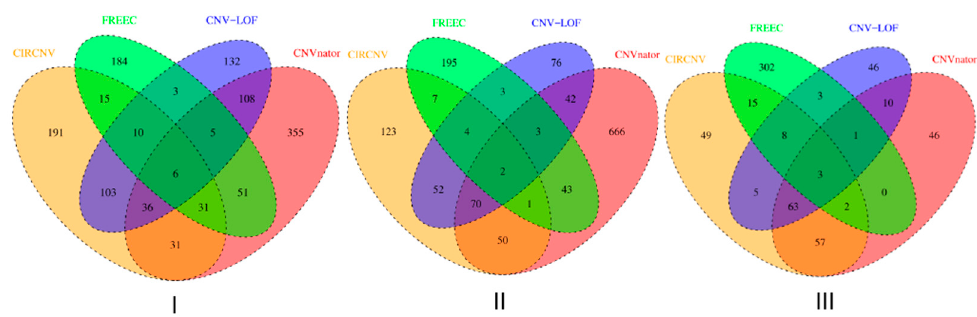
Figure 6. Result comparison of the four methods on the whole-genome sequencing data from sam- ples of EGAR00001004802_2053_1 ( I ), EGAR00001004802_2053_1 ( II ), and EGAD00001000144_LC